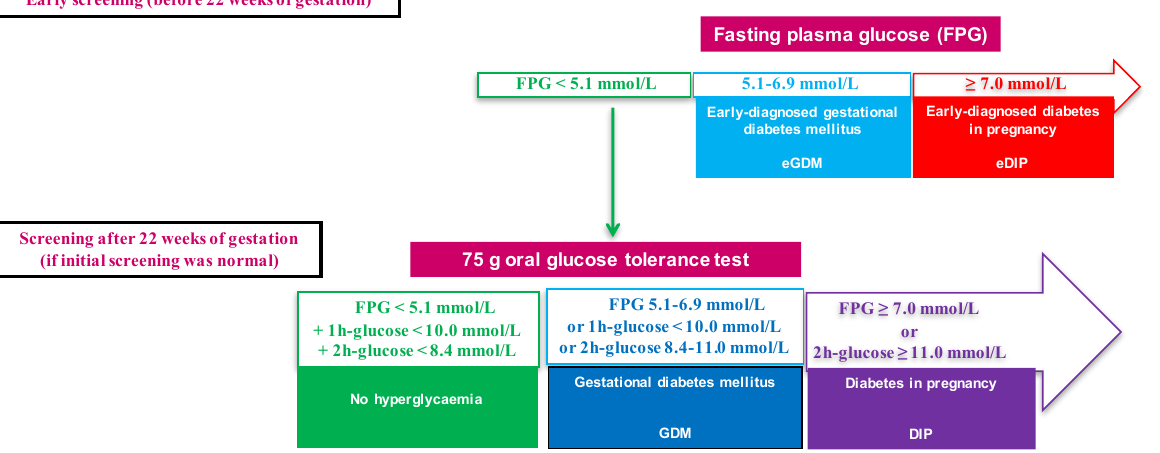
Figure 1. Screening for hyperglycaemia in pregnancy with diagnostic criteria.